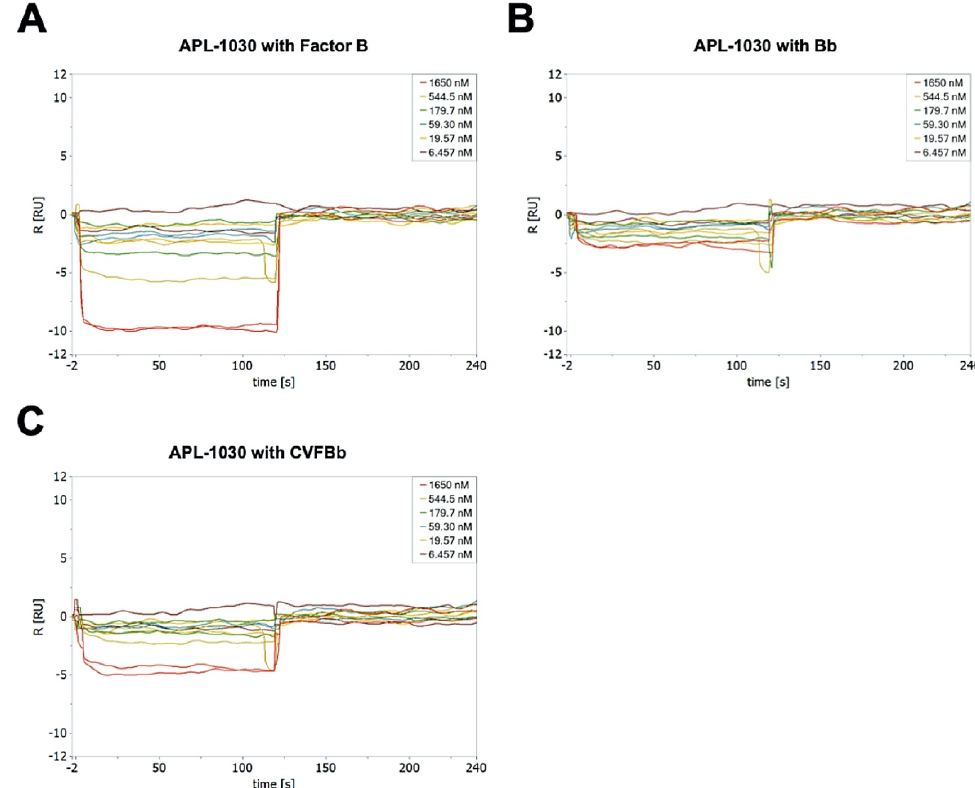
Figure A3. APL-1030 binding to complement components factor B ( A ), the Bb fragment ( B ), and the surrogate convertase, CVFBb (assembled cobra venom factor and Bb fragment, ( C ) by surface plasmon resonance.